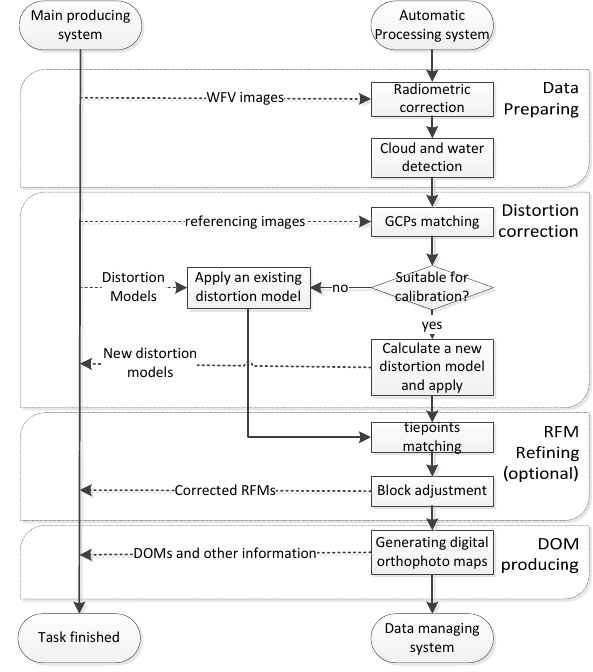
Figure 3. Workflow of the automatic processing system.